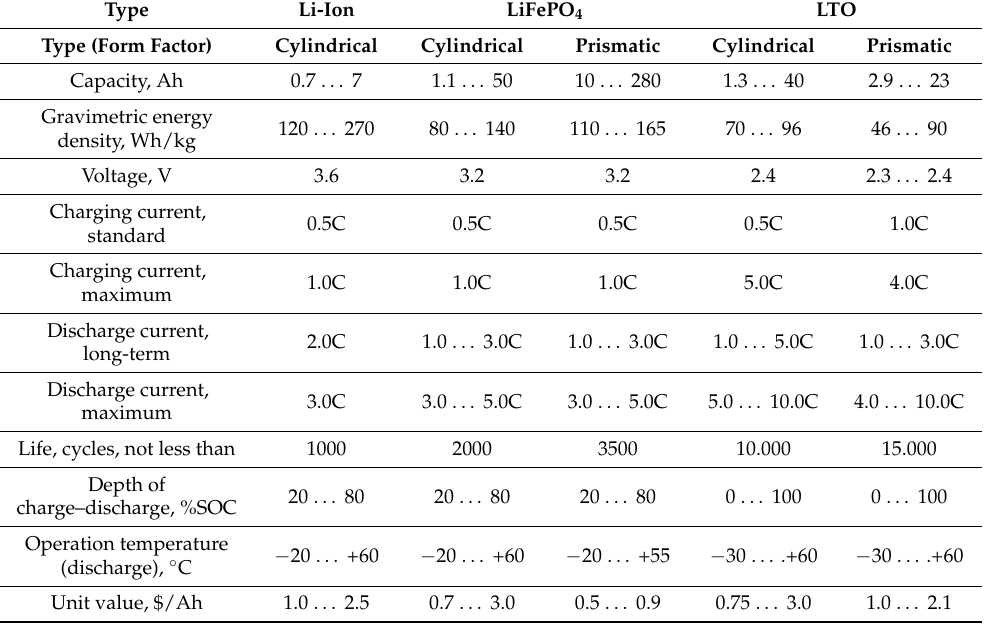
Table 1. Parameters of lithium battery